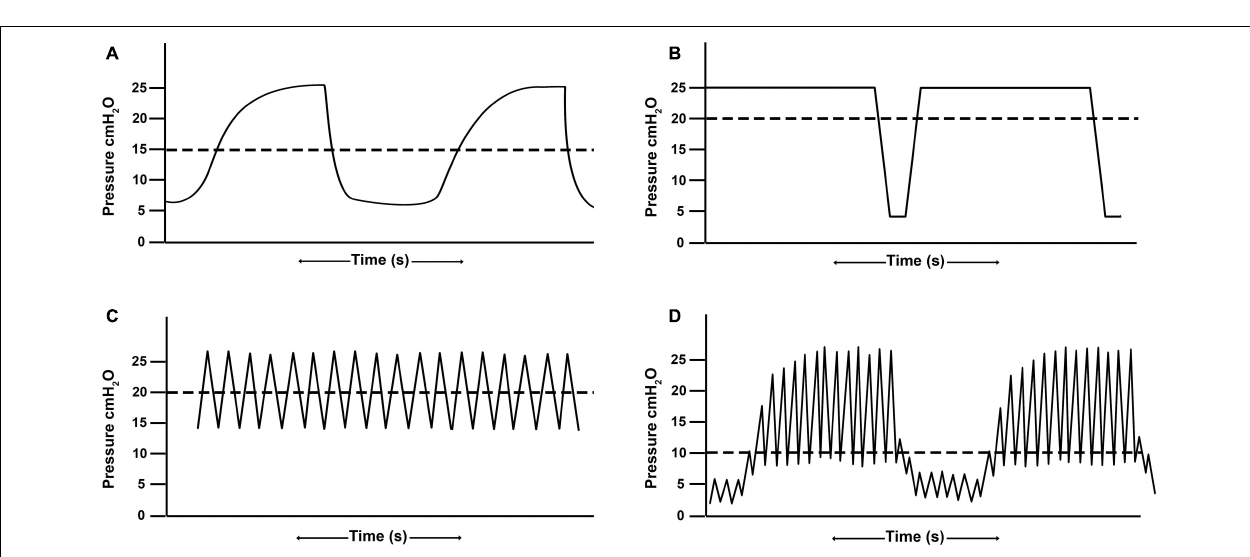
FIGURE 1 | Published with permission from Wong et al. (2019) Bubble plot demonstrating mortality rates associated with pediatric acute respiratory distress syndrome by year of study and study design (observational—blue and RCT—red). The size of the bubbles are proportional to the total number of patients recruited into the individual